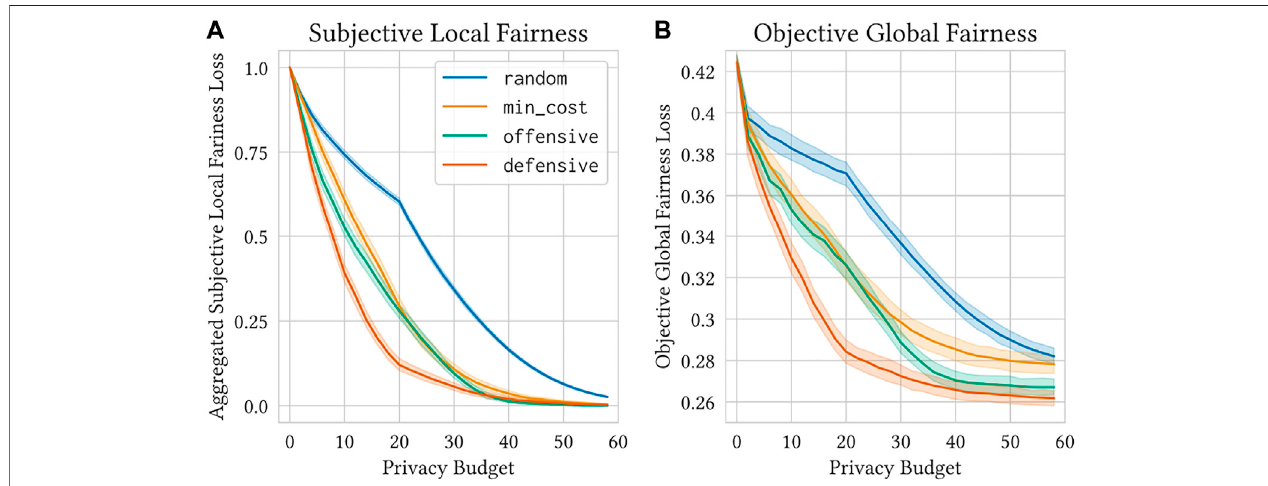
FIGURE 2| The defensive strategy outperforms the other strategies with respect toboth local and global fairnessunder privacy constraints. We show theaverage subjective local fairness loss (A) and the average objective global fairness loss (B) across a range of privacy budgets for random , min_cost , offensive ,